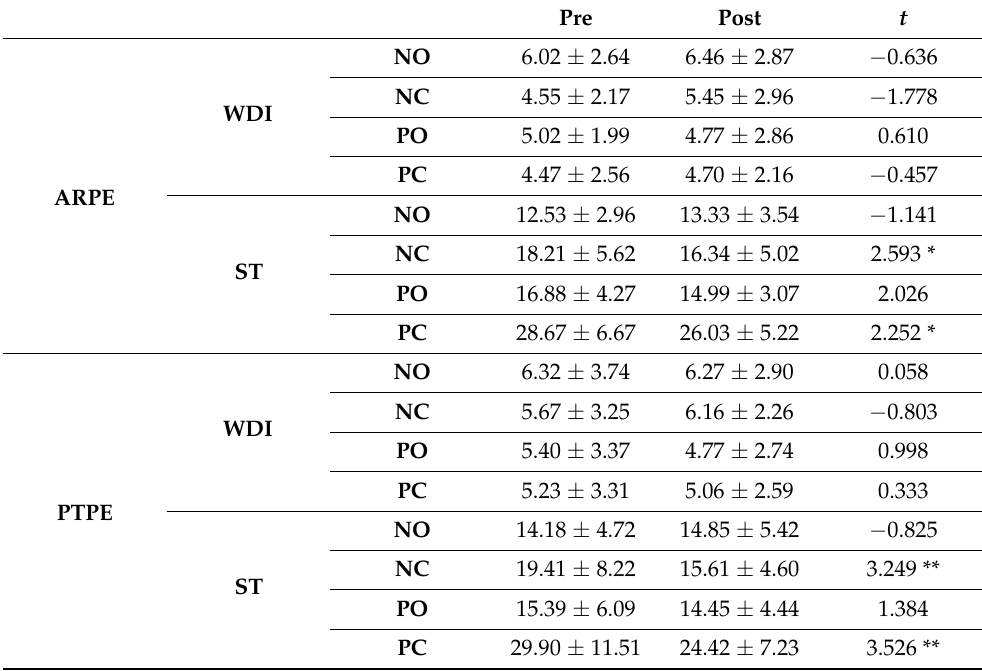
Table 6. Comparison of dynamic balance within a group after intervention.